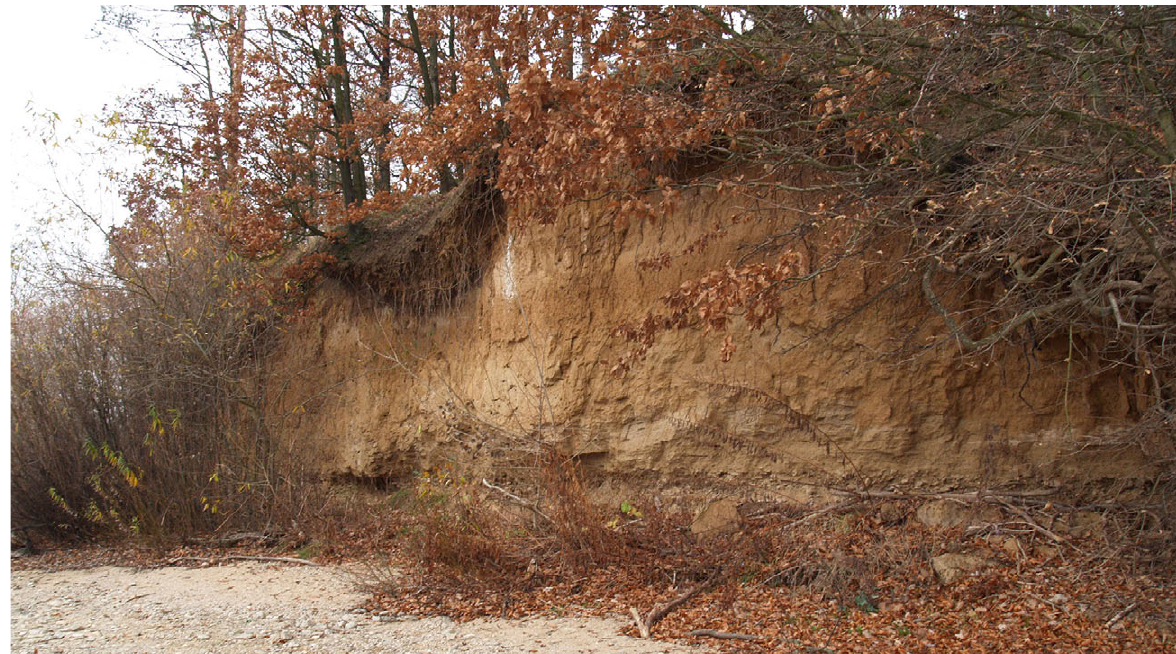
Fig. 5. Abrasion cliff developed in Quaternary loess on the Osada, Brno dam (Photo: K. Kirchner,